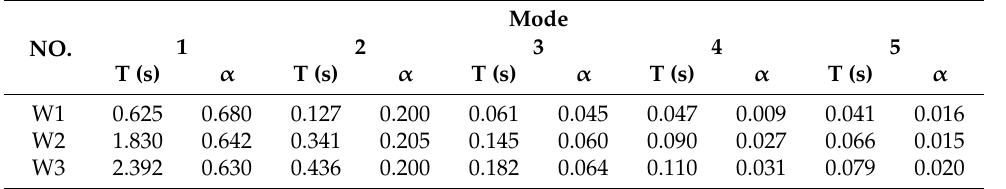
Table 1. Modal properties of shear wall structures.